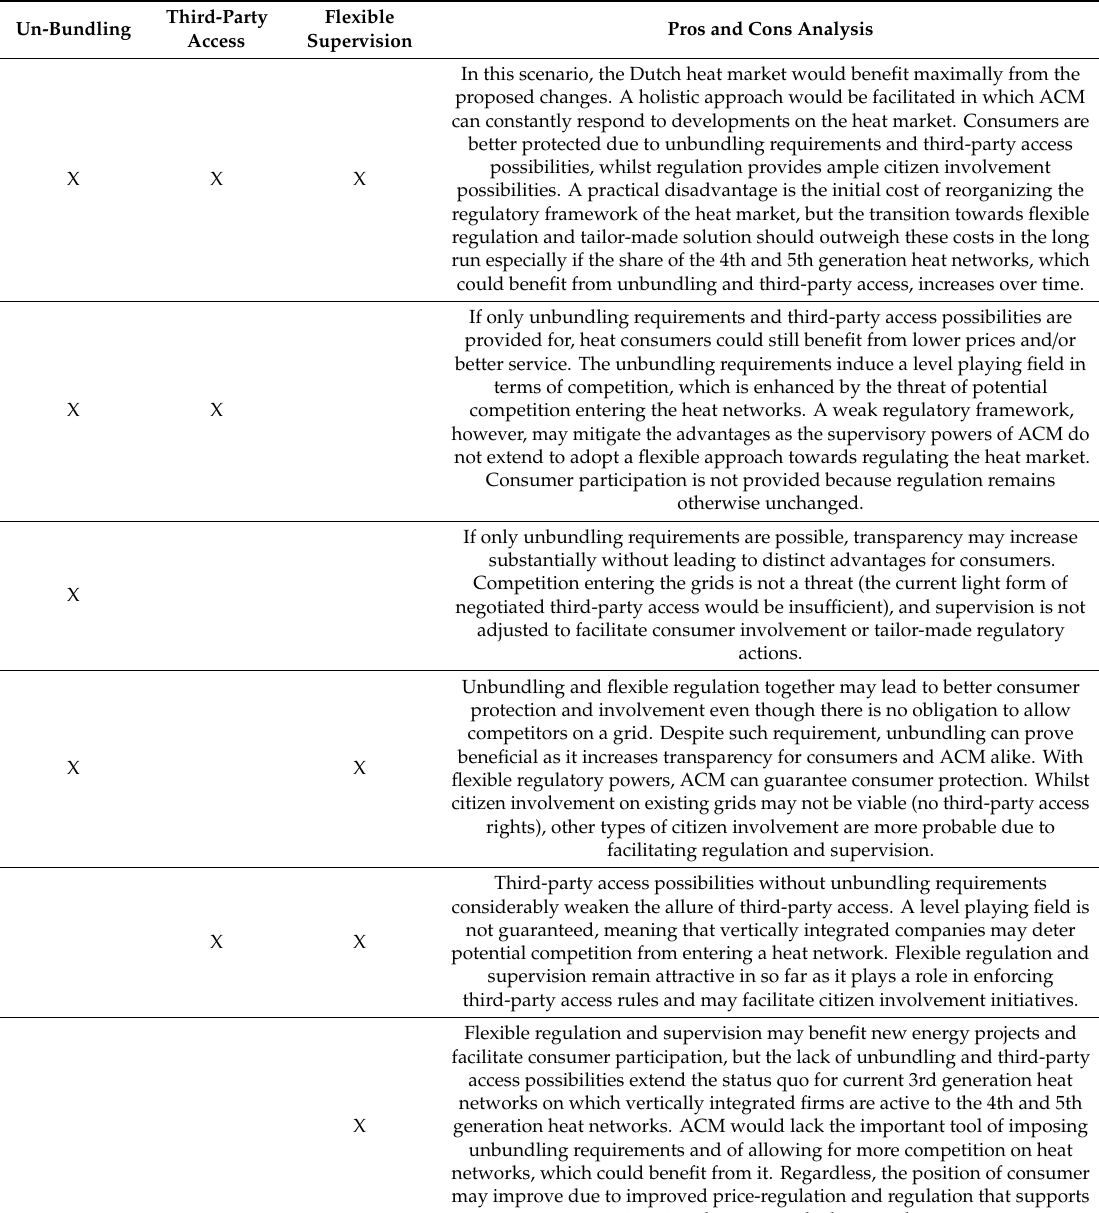
Table 1. Scenario